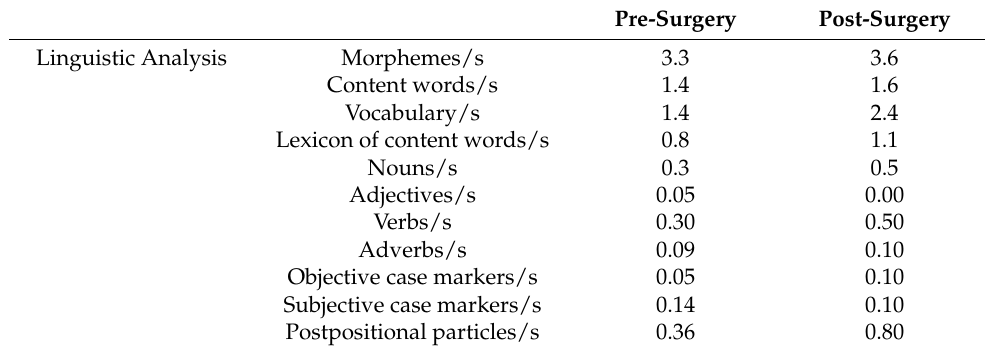
Figure 1. Brain magnetic resonance imaging (MRI). Fluid-attenuated inversion-recovery (FLAIR) MRI shows multiple cortical and subcortical tubers (arrows). Subependymal nodules are indicated by arrows. Table 1. Results of speech analysis using artificial intelligence and intelligence quotient